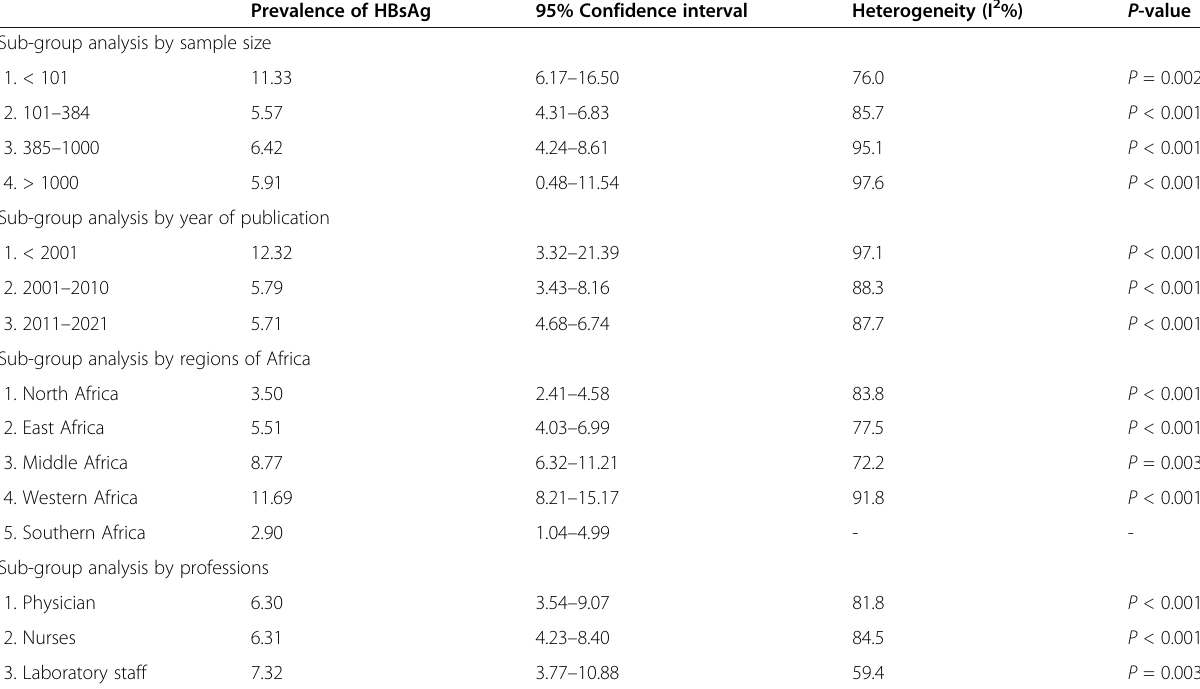
Table 4 Showing sub-group analysis of HBV prevalence by sample size, year of publication, regions of Africa, and HCWs professions in Africa Prevalence of HBsAg 95% Confidence interval Heterogeneity (I 2